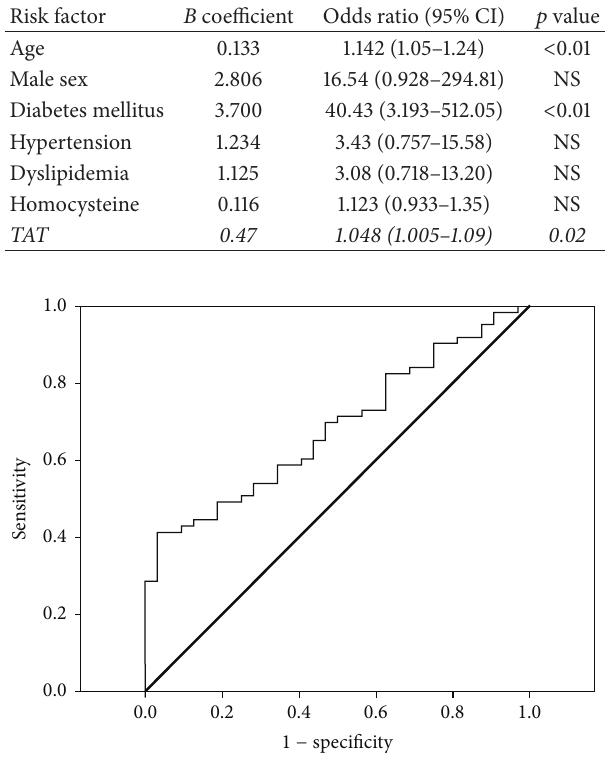
Figure 1: TAT sensitivity and specificity for